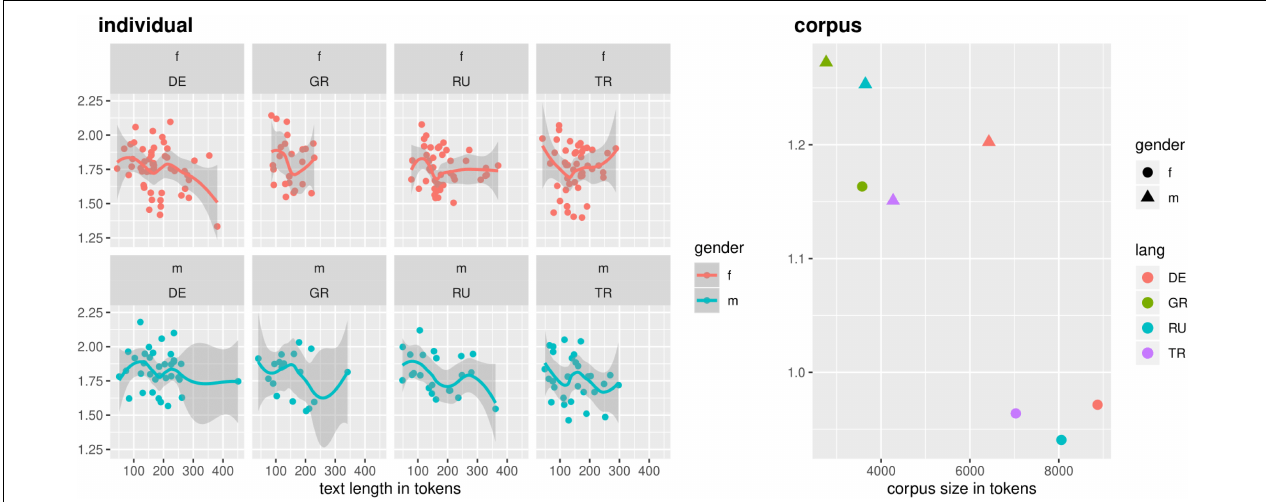
FIGURE 4 | Transformed TTR in maj-German (formal-written) RUEG